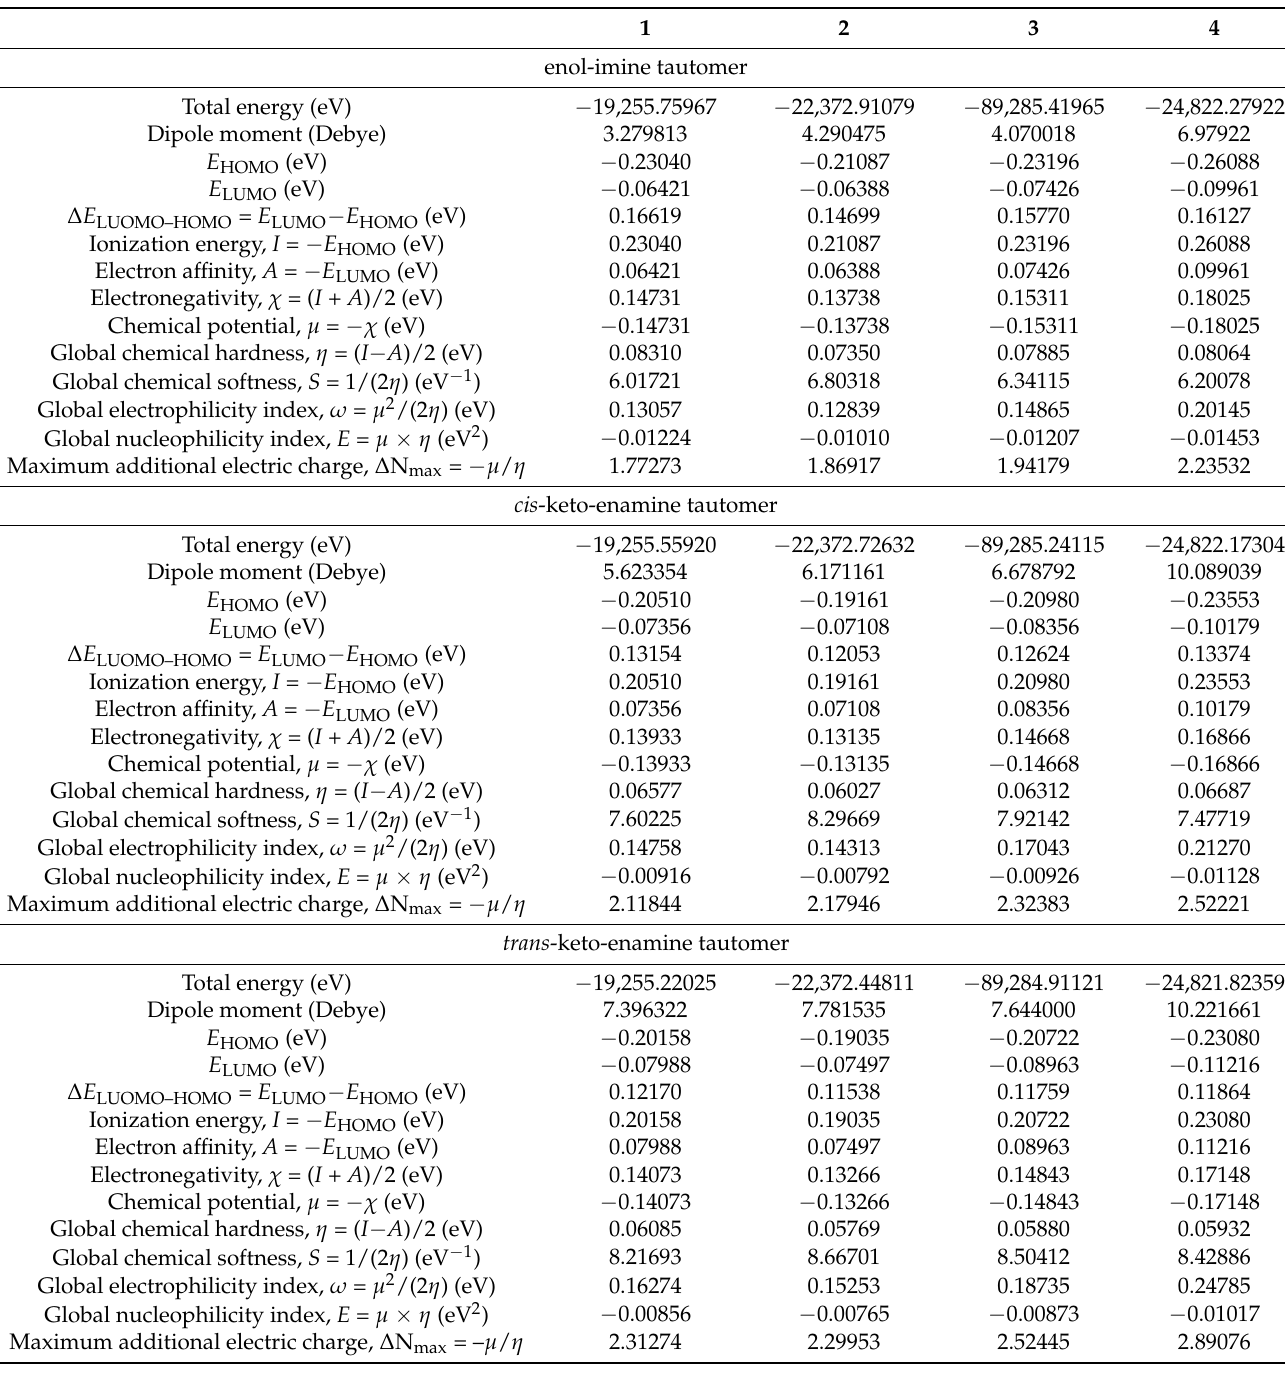
Table 3. Total energy, dipole moment, frontier molecular HOMO and LUMO orbitals, gap value, and descriptors for 1–4 in gas phase, obtained by using the B3LYP/6-311++G(d,p)